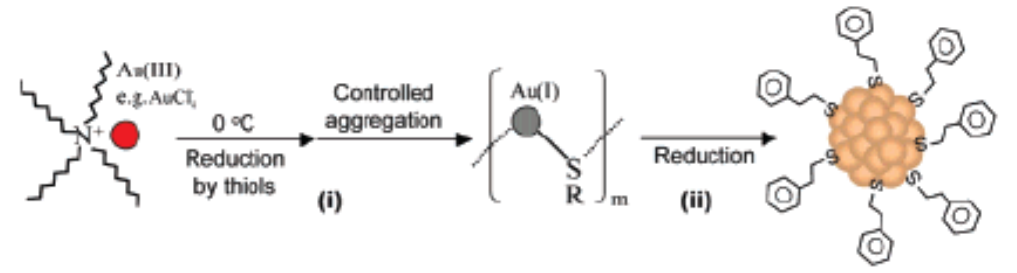
Figure 4. The preparation of Au